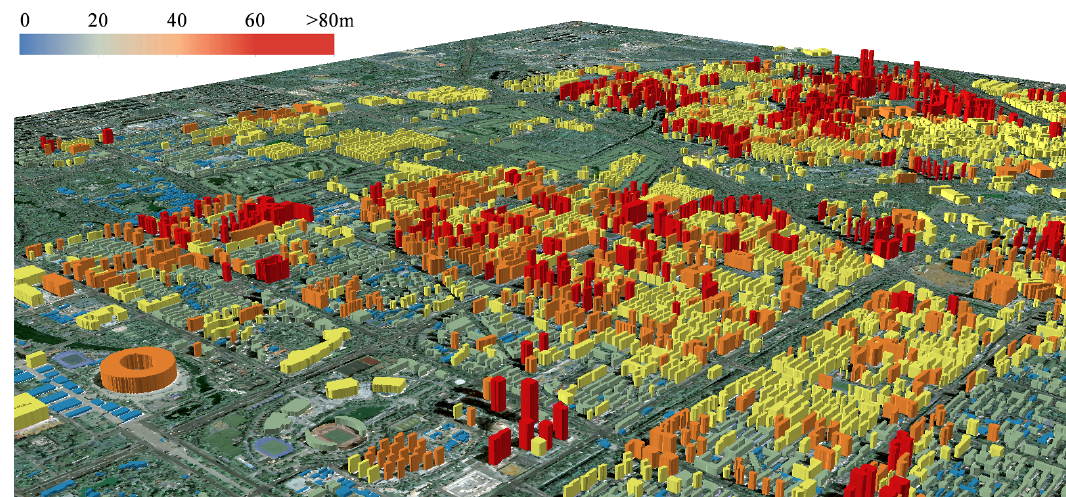
Figure 14. The 3D information results of our method.